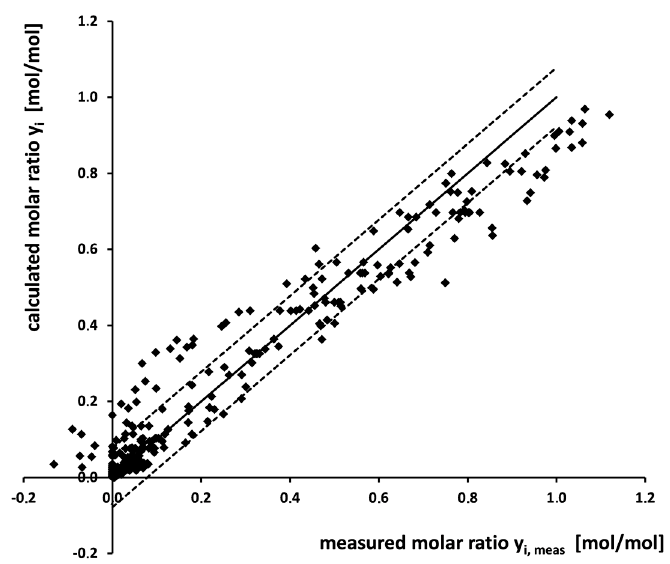
Figure 8. Parity plot of the molar ratio measured y i,meas and the molar ratio calculated y i . The solid line though the origin has a slope of one. The dashed lines have a slope of one and are shifted by the standard derivation.